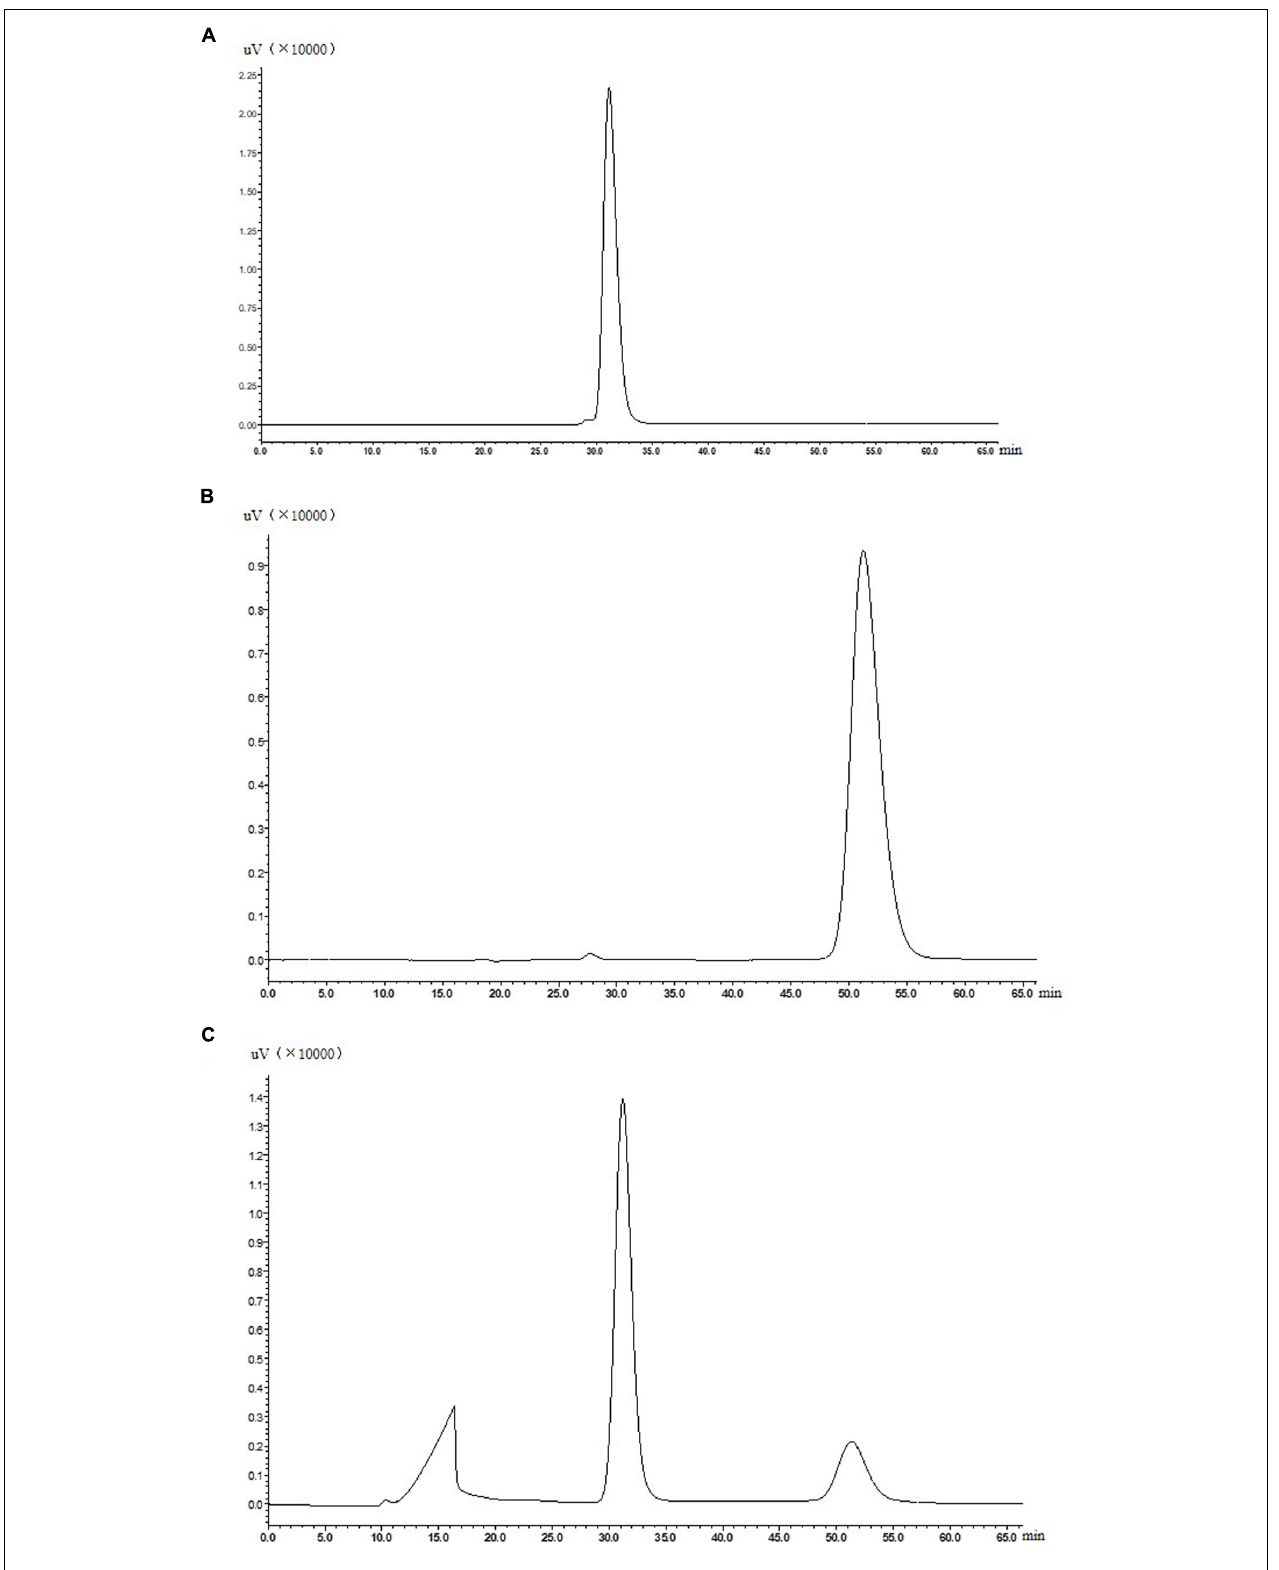
FIGURE 4 | Authentic allitol (A) , authentic D -allulose (B) , and a sample of reaction solution for the biotransformation of allitol into D -allulose catalyzed by purified ADH (C) .